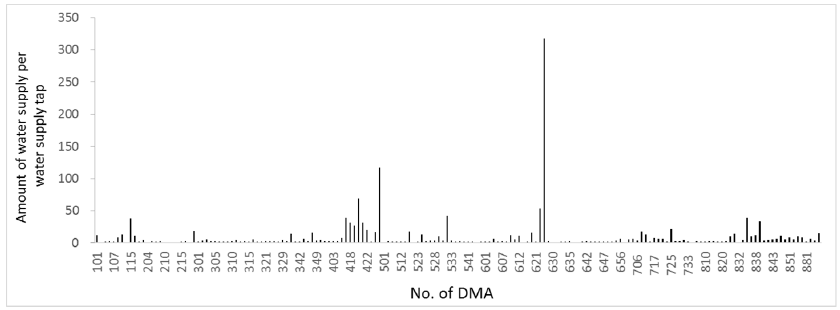
Figure 6. Data on Volume of Water Supply per Demand Junction in Incheon’s DMA.